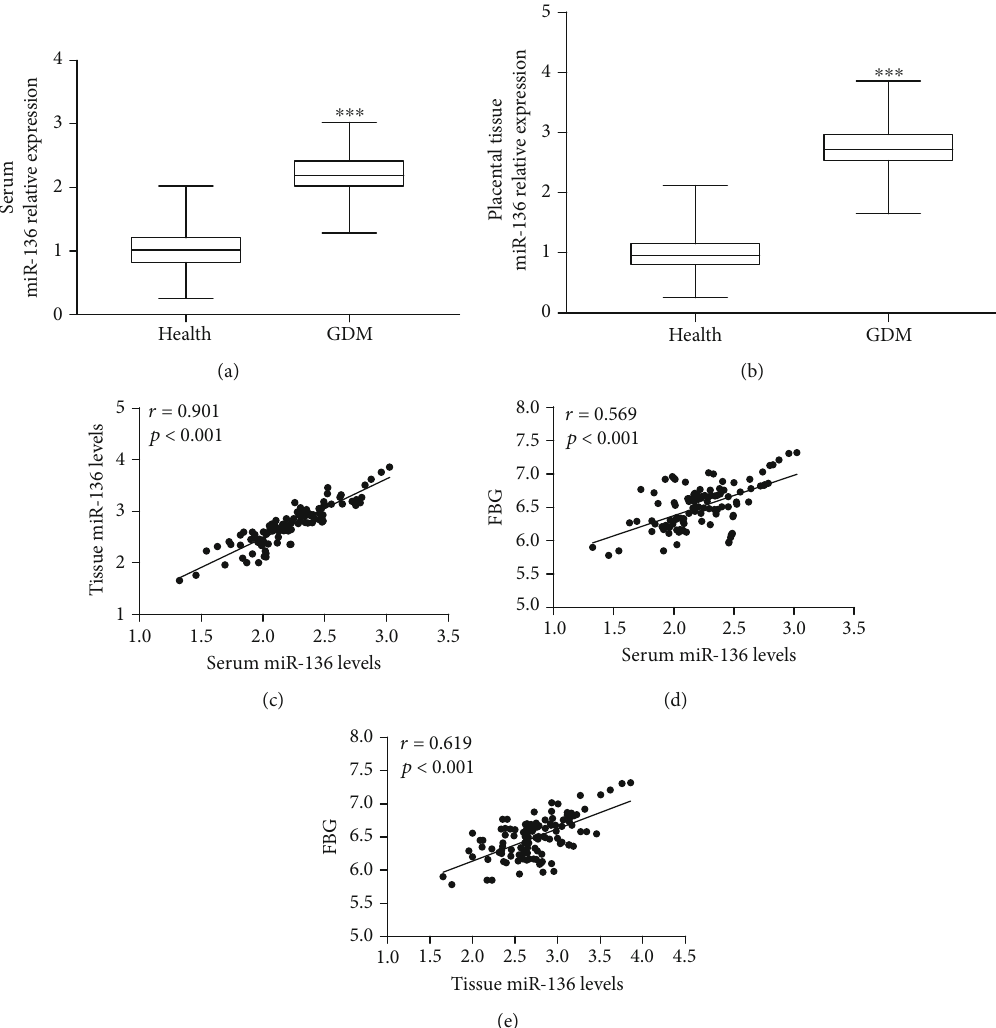
Figure 1: Expression of miR-136 in GDM patients and its diagnostic value evaluation. (a) GDM patients had higher serum miR-136 expression than the healthy controls ( ∗∗∗ P < 0 : 001 ). (b) Expression of miR-136 in placental tissues was elevated in GDM patients compared with the healthy pregnancy women ( ∗∗∗ P < 0 : 001 ). (c) Serum miR-136 was positively correlated with tissue miR-136 in GDM patients ( r = 0 : 901 , P < 0 : 001 ). (d) Serum miR-136 levels were positively correlated with patients ’ FBG ( r = 0 : 569 , P < 0 : 001 ). (e) A positive correlation was observed between tissue miR-136 and FBG in GDM patients ( r = 0 : 619 , P < 0 : 001 correlated with miR-136 levels in GDM patients (both P < 0 : 001 , Figures 4(g) and 4(h)).